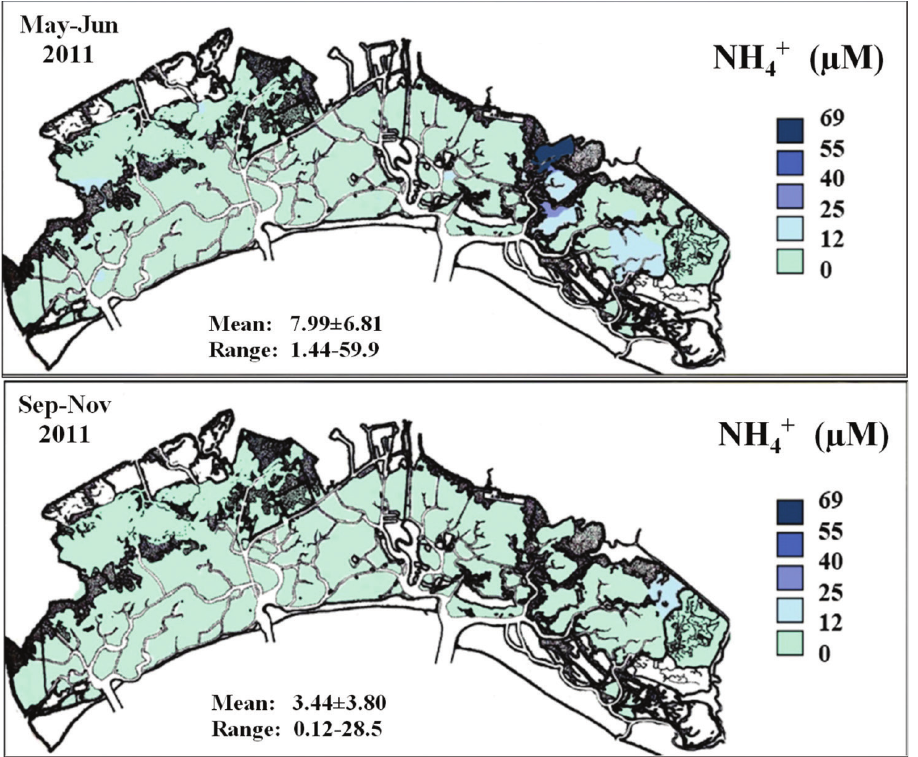
Figure 6. Map of ammonium distribution obtained for the whole lagoon by sampling 118 sites in spring and in autumn